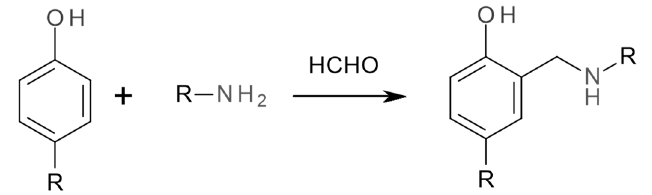
Figure 1. Scheme of Mannich base synthesis reaction.